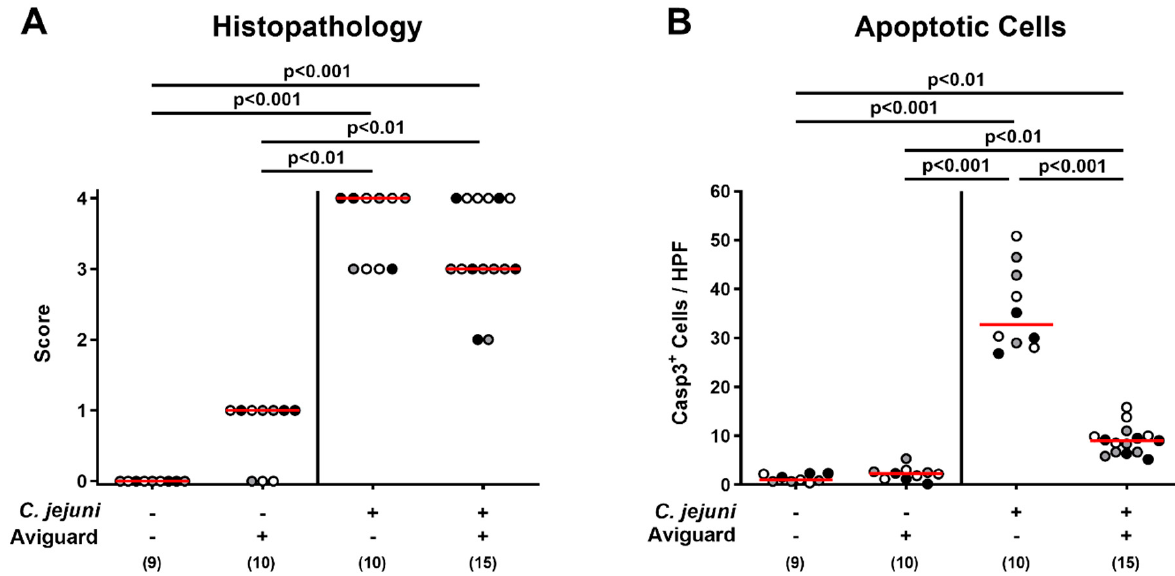
Figure 4. Aviguard ® treatment and microscopic inflammatory changes in the colon of C. jejuni -infected microbiota-depleted IL-10 − / − mice. Following C. jejuni strain 81-176 infection on days 0 and 1, microbiota-depleted IL-10 − / − mice were perorally treated with Aviguard ® or placebo on days 2, 3, and 4. On day 6 post-infection, ( A ) the histopathological changes in the colonic mucosa and lamina propria were quantified by a standardized histopathological scoring system. Furthermore, ( B ) the average numbers of colonic epithelial apoptotic (Casp3 + ) cells were determined microscopically from six high power fields (HPF, 400 × magnification) per mouse in immunohistochemically stained colonic paraffin sections. Medians (red bars), significance levels ( p values) calculated by the Kruskal–Wallis test and Dunn’s post-correction ( A ) or by the ANOVA test with Tukey post-correction ( B ) and numbers of analyzed mice (in parentheses) are indicated. Data were pooled from three independent experiments (as indicated by black, white, and gray circles).